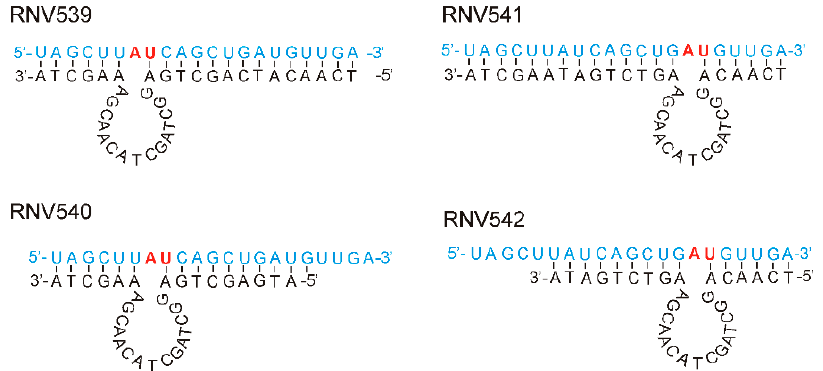
Figure 1. Design of novel “10–23” motif antimiRzymes RNV539, RNV540, RNV541 and RNV542 targeting miR-21. The designed antimiRzymes had a 15 nt catalytic loop and two substrate binding arms of varying sizes. In this design, the antimiRzymes (black) and its miR-21substrate (blue) is hybridized via Watson–Crick base pairing and cleavage occurs at the A:U dinucleotide position (red). Although the designed antimiRzymes share an identical catalytic domain, the miR-21 cleaving Molecules 2019 , 24 , x FOR PEER REVIEW efficacy of individual antimiRzyme sequences could be affected by various other factors such as targeting affinity, capabilities to adopt the arm-loop-arm structure, and catalytic properties in the presence of divalent metal ions [20], and this has to be experimentally tested. To determine the catalytic activity of the antimiRzymes, initially we performed in vitro cleavage experiments by incubating the antimiRzymes RNV539-RNV542 with a 5 ′ -fluorescent dye (FAM) labelled synthetic miR-21 RNA template in presence of 10 mM Mg 2+ divalent cations at different time points over two hours. The results demonstrated that both RNV541 and 542 displayed notable miR-21 cleavage in a time-dependent manner (Figure 2), whereas RNV539 and RNV540 were not effective in cleaving miR- 21 RNA template as it showed low or no catalytic efficacy. In particular, RNV541 showed 40% cleavage efficiency after 120 min incubation which was almost twice the cleavage rate achieved with RNV542. In line with these initial results of miR-21 RNA template cleavage, we have used the antimiRzyme RNV541 for further analyses in miR-21 overexpressed cancer cells, including glioblastoma U87MG and triple negative breast cancer MDA-MB-231 cells.